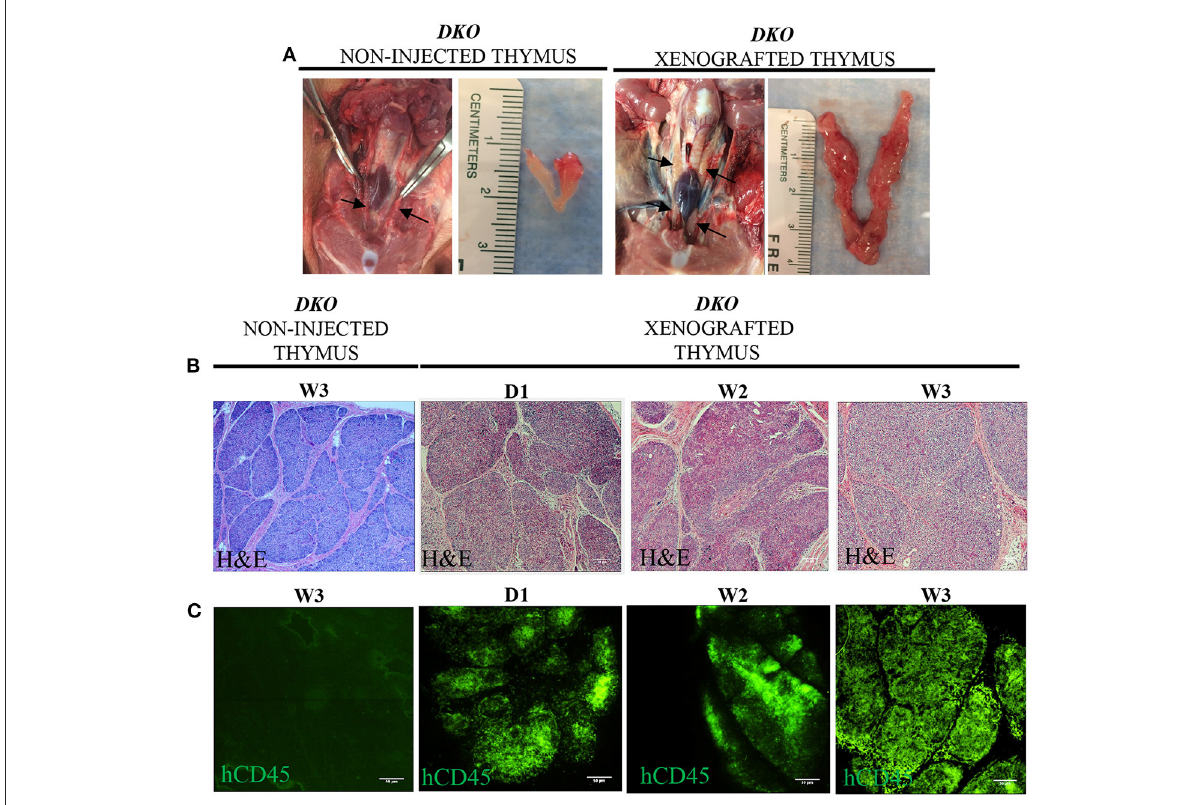
FIGURE8 Macroscopic, microscopic and human CD45 immunofluorescence staining in the thymi of xenografted DKO pigs. (A) Representative macroscopic anatomy images of the thymus of non-injected and xenografted pigs. The xenografted thymus was noticeably expanded and larger than the non-injected thymus. (B) H&E histological structure (20x magnification) of thymi from non-injected pigs at 3 weeks and the thymi of three xenografted pigs at birth ( n = 1), two ( n = 1), and 3 weeks ( n = 1) of age. (C) Immunofluorescence staining for human CD45 + cells with FITC conjugated antibodies is also shown. Non-injected thymus served as a negative control, showing no